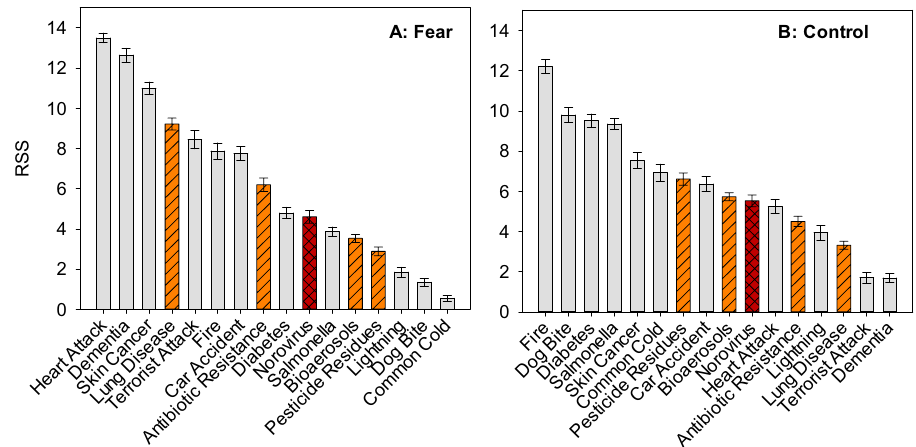
Figure 2. The ranking of ratio-scaled scores (RSS) relating to ( A ) fear and ( B ) control for the 16 risk items (n = 806). Error bars represent 95% confidence intervals. Red striped bar shows risk associated with norovirus and orange, crosshatched bars show other environment-associated risks.